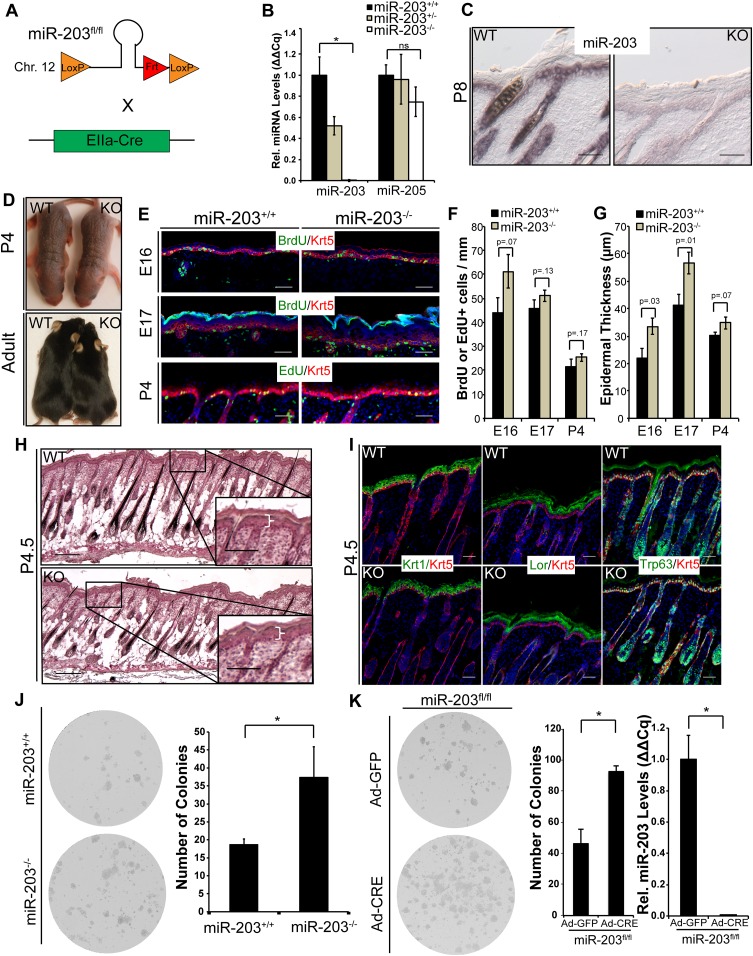
Loss of miR-203 modestly impairs embryonic epidermal development.(A) Schematic of miR-203 conditional allele generation and knockout strategy. (B) Validation of miR-203 ablation by qPCR from isolated epidermal samples (n = 3 biological replicates, * p < 0.05, ns = non-significant, Student's t-test two-sided). (C) Validation of miR-203 ablation within the epidermis by in situ hybridization (Scale bar = 50 μm). (D) miR-203 knockout mice are visibly indistinguishable from wild-type counterparts. (E–G) miR-203 ablation results in mild epidermal hyperplasia during embryonic development. (n = 3 E16, n = 4 E17, and n = 3 p4 animals, p-value provided in figure, Student's t-test one-sided). (H) Representative hematotoxylin and eosin image from p4.5 animals, demonstrating restored normal skin morphology in neonatal animals. (Scale bars = 50 μm for inset and 100 μm for main images) (I) Epidermal differentiation is not compromised by loss of miR-203. (Scale bars = 50 μm) (J) miR-203−/− primary keratinocytes are more clonogenic than wild-type counterparts (representative results from 3 experiments, *p < 0.05, Student's t-test two-sided). (K) Conditional ablation of miR-203 from passaged miR-203fl/fl keratinocytes results in higher clonogenicity (representative results from n = 3 independent experiments, mean ± standard deviation displayed, *p < 0.05, Student's t-test, two-sided).